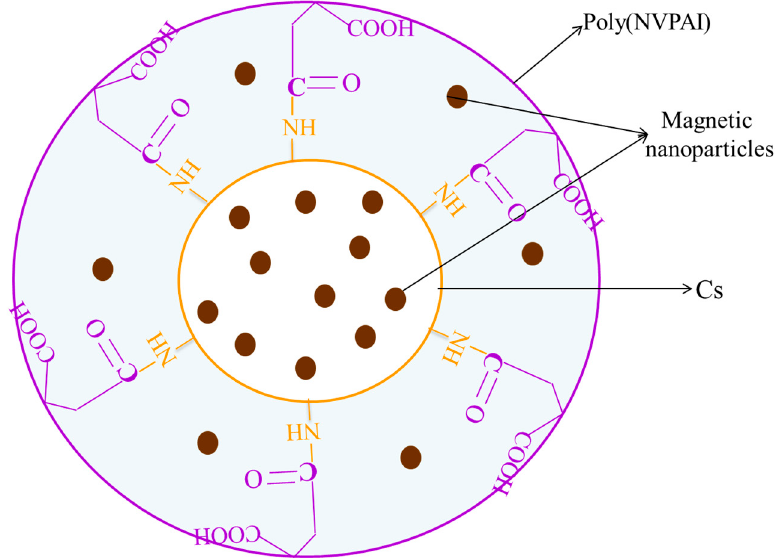
Figure 1. Schematic illustration of magnetic NCs based on CS and poly(NVPAI) containing magnetic nanoparticles.